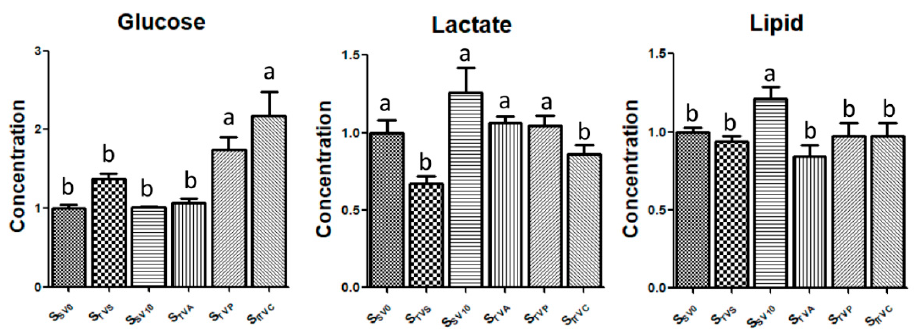
Figure 8. Relative concentrations of the lipids, lactate and glucose in six different serum samples. Note: Different letters represent significant differences at p < 0.05.